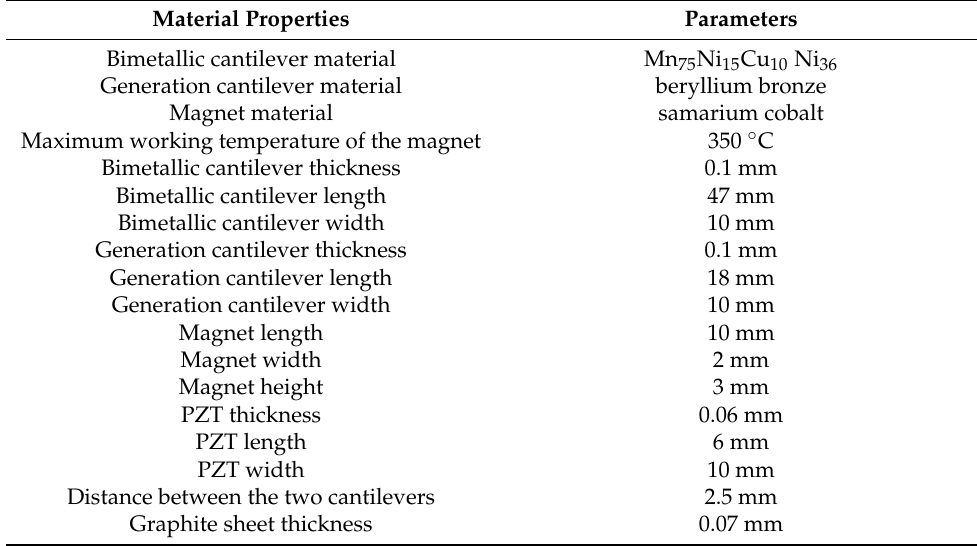
Table 2. The material properties and geometric parameters of the energy